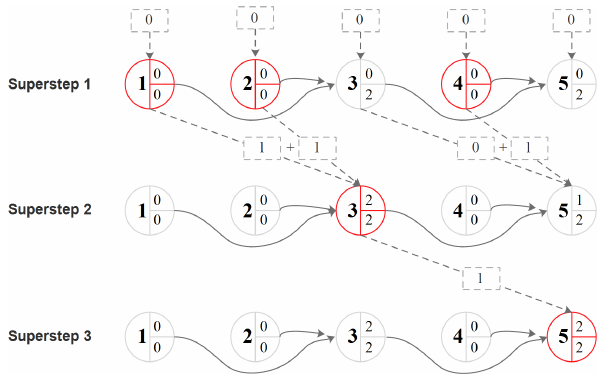
Figure 4. Demonstration of the parallel simulation of subbasin models of the example watershed (Fig. 1a) using the Pregel oper- ator of GraphX (the number in the left part of a vertex is the sub- basin number, the lower right number denotes how many upstream subbasins are directly connected to the current subbasin, the upper right number indicates the number of directly upstream subbasins for which simulation has been completed, and a red vertex denotes that the corresponding subbasin model is simulated in that super- step).